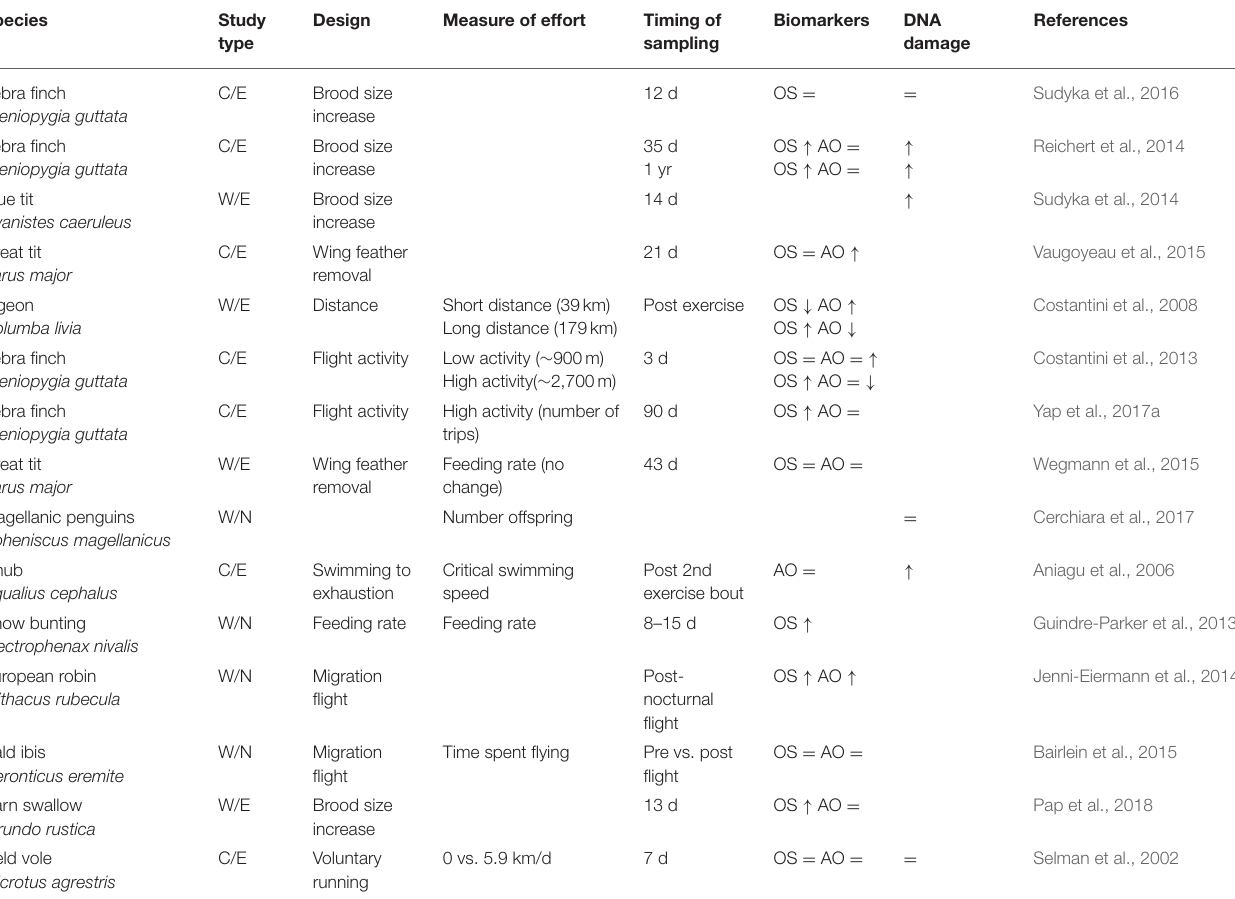
TABLE 1 | Published animal studies that assess “effort” and its impact on oxidative stress (OS), antioxidant biomarkers (AO), and DNA damage (telomere length, comet assays).